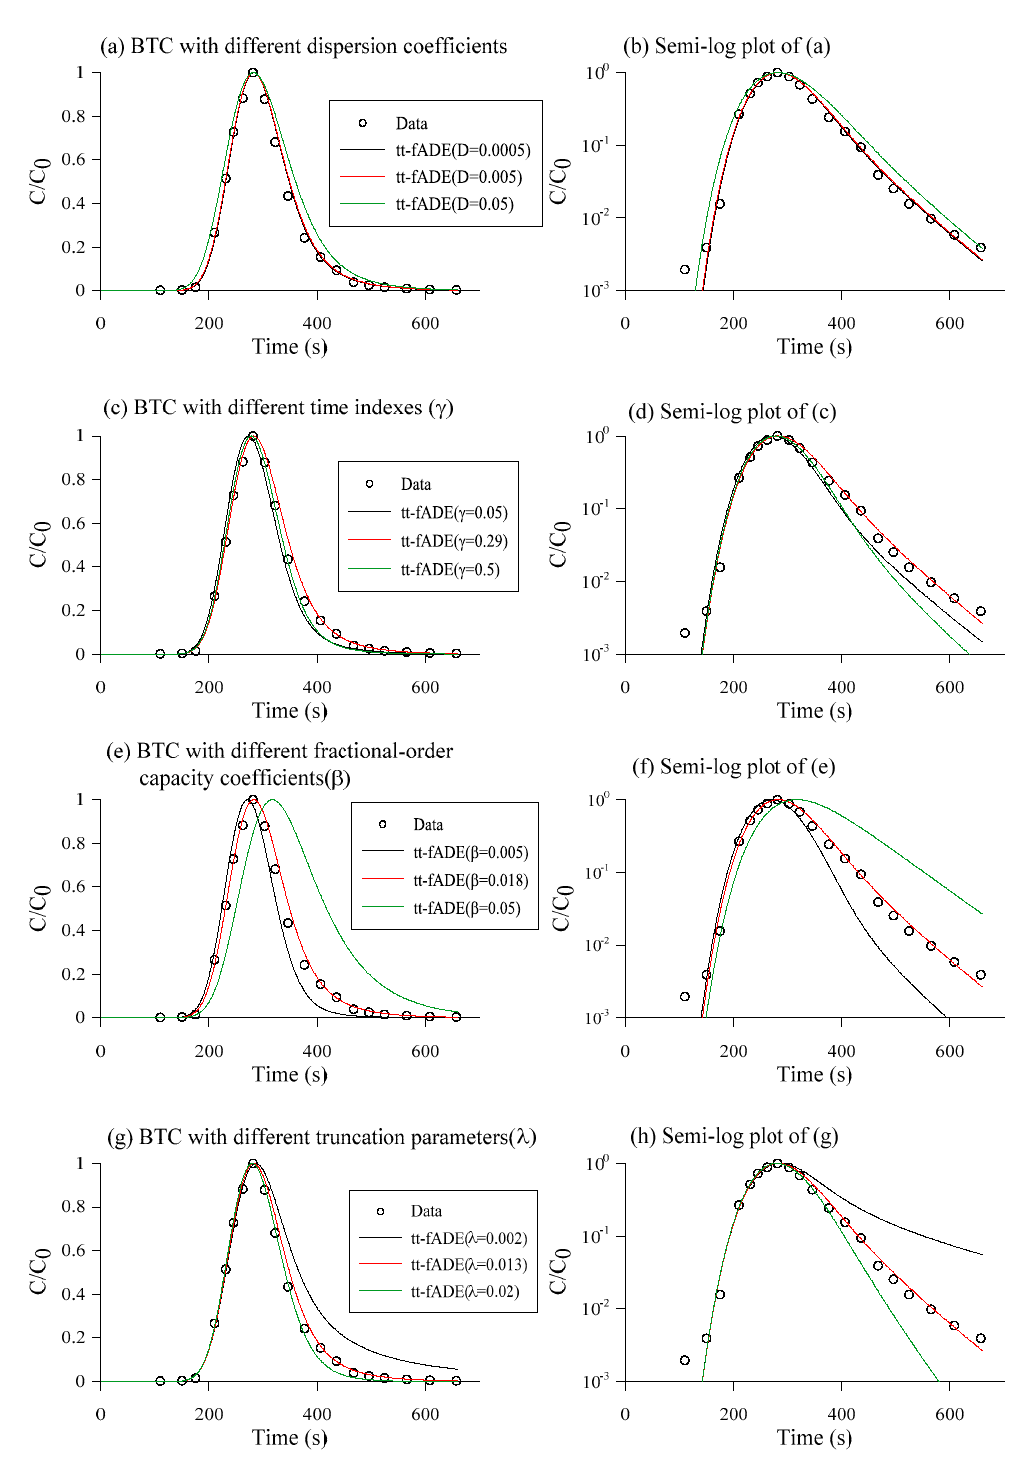
Figure 7. Sensitivity analysis for coefficients in the tt-fADE model.